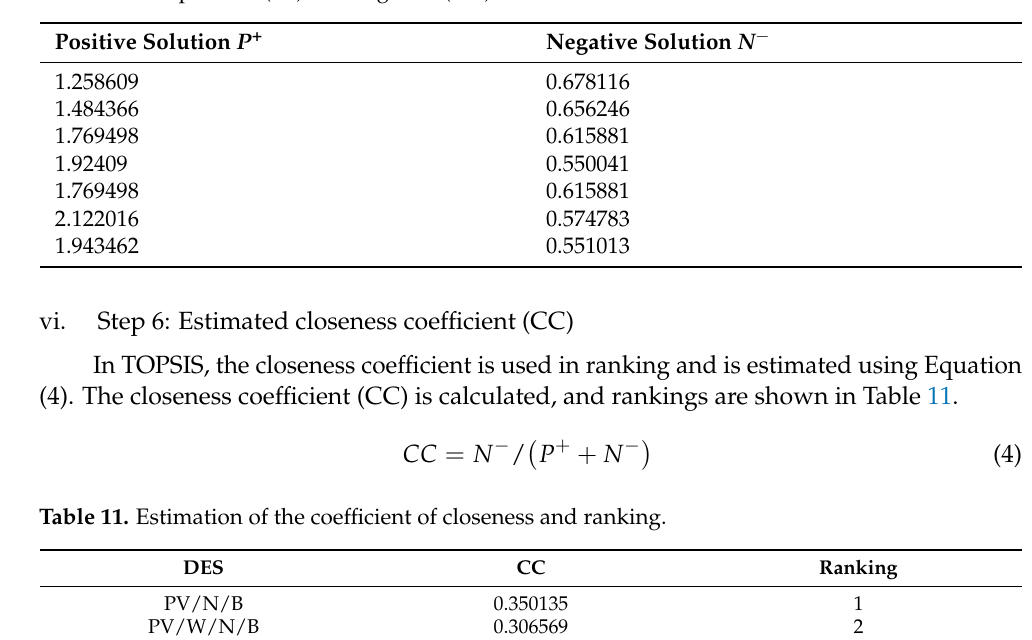
Table 10. The positive ( P + ) and negative ( N − ) solution.